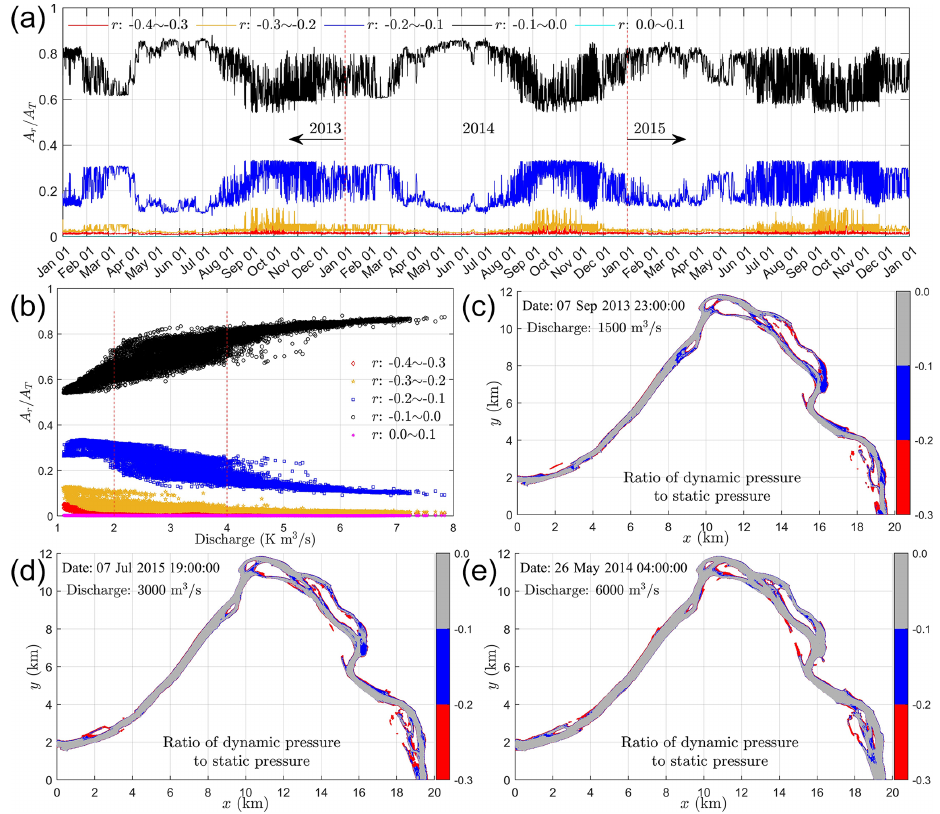
Figure 11. The variations of the relative pressure ratio area ( A r /A T ) with time (a) and discharge (b) , as well as the spatial distribution of each pressure ratio range at low- (c) , medium- (d) , and high-flow (e) conditions.